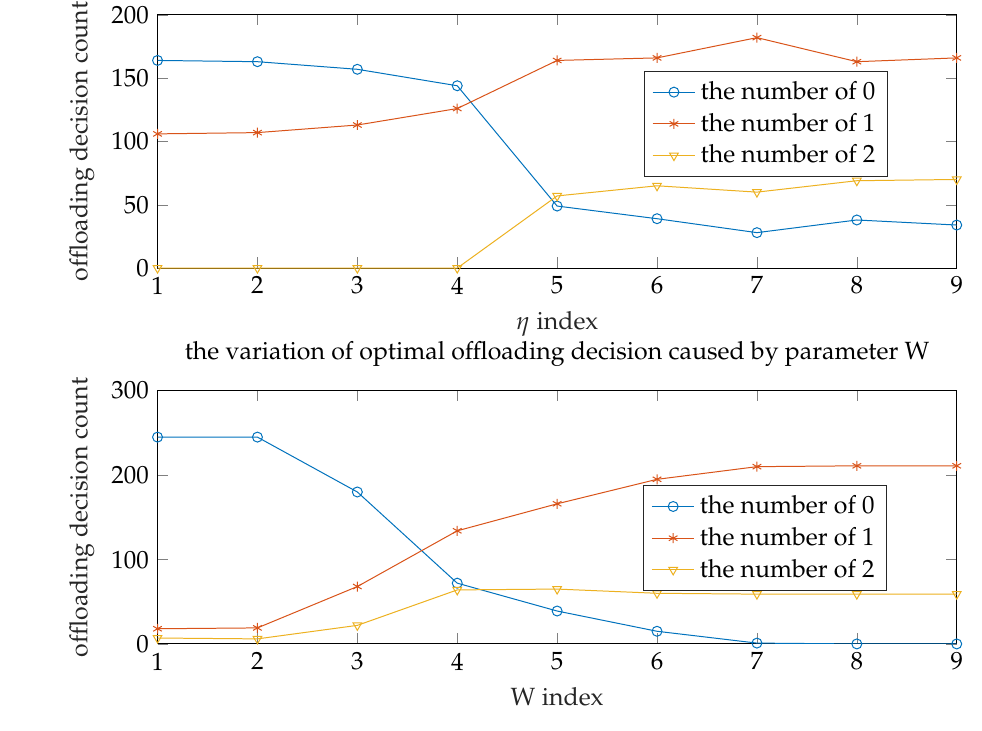
Figure 7. Offloading decision